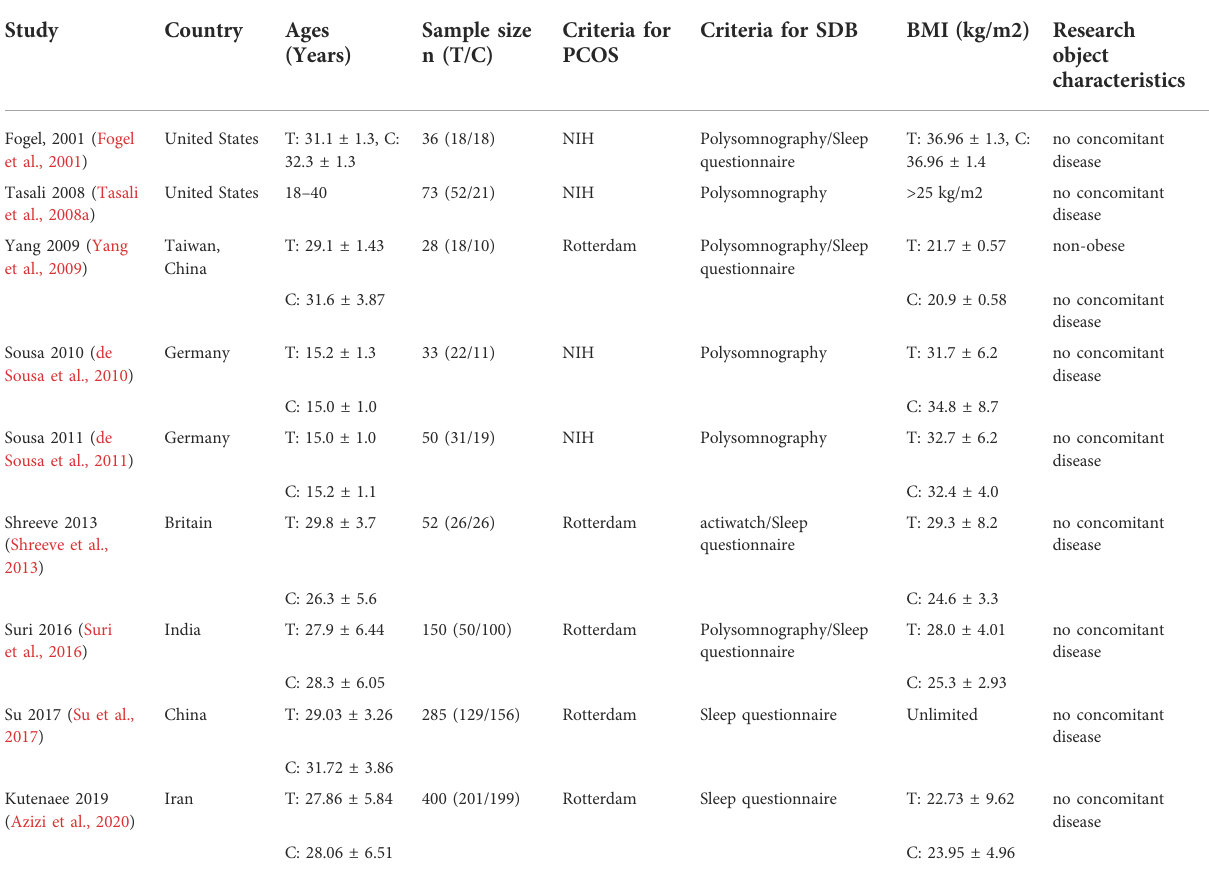
TABLE 1 Basic features of the included studies.